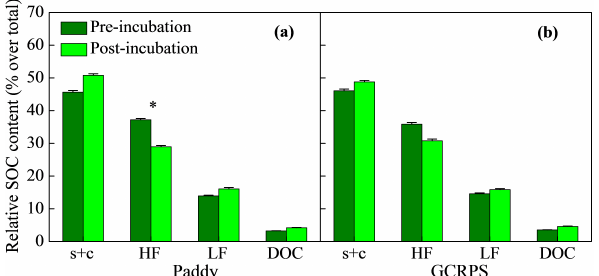
Figure 6. Relative SOC fractionation (% of total) of topsoils (0– 20cm) from either paddy sites or GCRPS-grown rice fields for the different physically separated fractions before and after a 200- day incubation period. s + c is fraction <53µm, HF/LF represent heavy/light fraction >53µm, and DOC represents dissolved organic carbon <0.45µm. For GCRPS, n is 18 and for paddy sites, n is 18 (random selection of 18 out of 49 paired sites). Error bars denote SEM. The asterisk indicates significant differences between pre- and post-incubation ( P